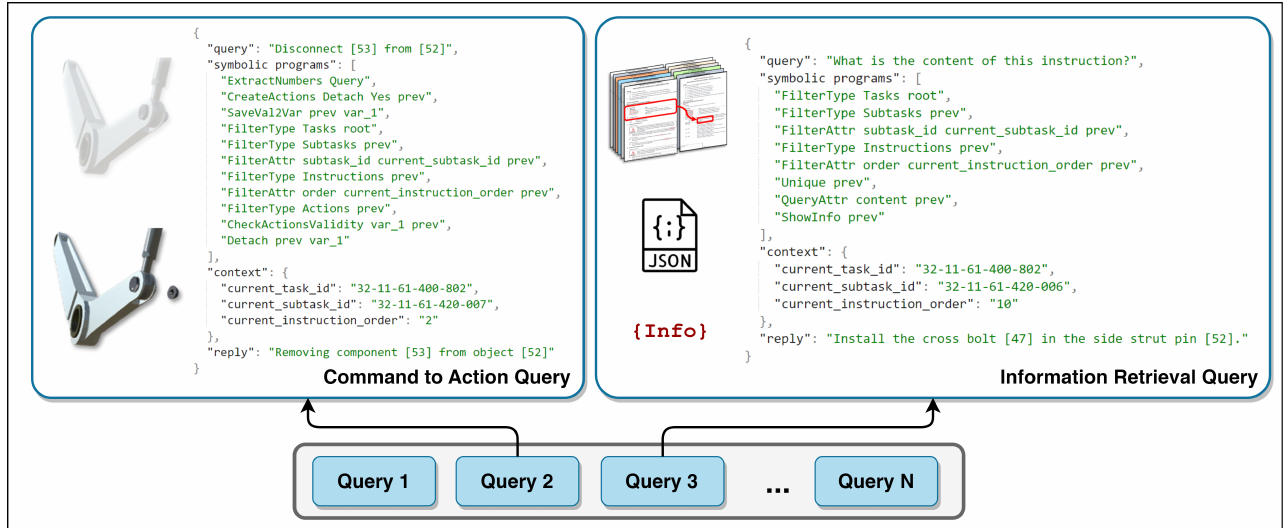
Figure 4. Neuro-symbolic dataset of